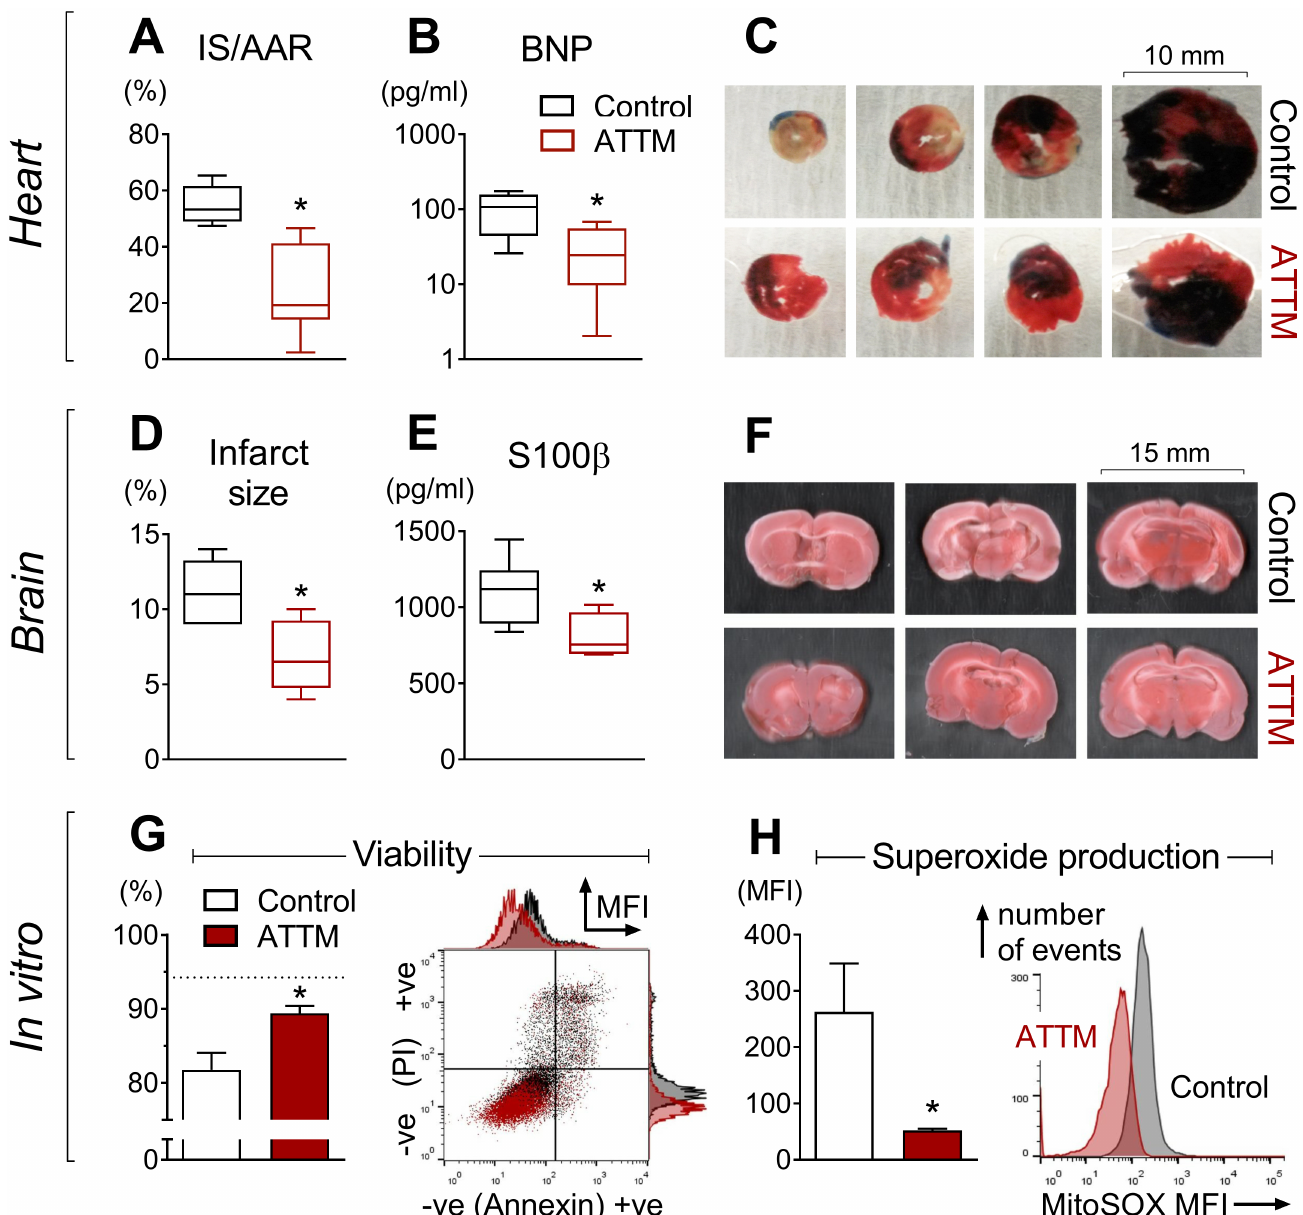
Fig 5. Organ-specific ischemia/reperfusion and cellular anoxia/reoxygenation. Ammonium tetrathiomolybdate(ATTM) confers cardioprotection (A–C, n = 6), neuroprotection (D–F, n = 6), and cytoprotection (G and H, ATTM 5.5 mM, n = 3). In (C), Evans blue dye shows the myocardialarea not at risk. In (C) and (F), viable tissue appearspink/red, with non-viabletissue depictedas white/beige. In (G) a representativeflow cytometry plot denotes positive (+ve) and negative ( − ve) labelingfor propidiumiodide(PI) and AnnexinV, expressedas median fluorescence intensity (MFI). Here, ATTM and controls are depicted in dark red and black, respectively. Live cells (negativefor both labels)are shown in the bottom left quadrantand as a percentage of the total in the figure (G, left panel). The dotted line (G, left panel)shows viability in untreated cells (no ischemia/reperfusion or drugs). A representative fluorescence histogramof MitoSOX (mitochondrial superoxide production)is shown in (H), right panel. AAR, area at risk; BNP, B-type natriuretic peptide; IS, infarct size; S100 β ,S100 calciumbindingprotein β . * p < 0.05 using an unpaired t -test.